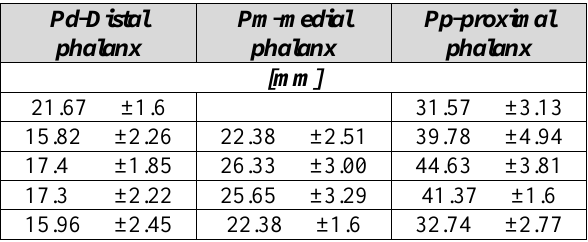
Table 1. Average and std of phalanges lengths [1].